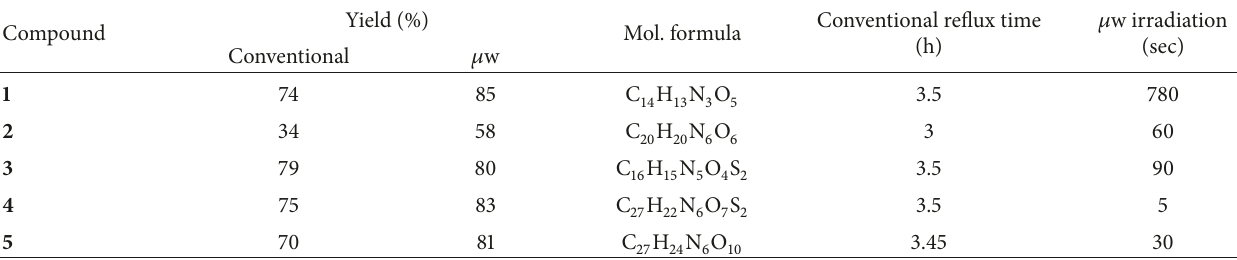
Table 1: Physical characteristics of compounds 1 – 5 .